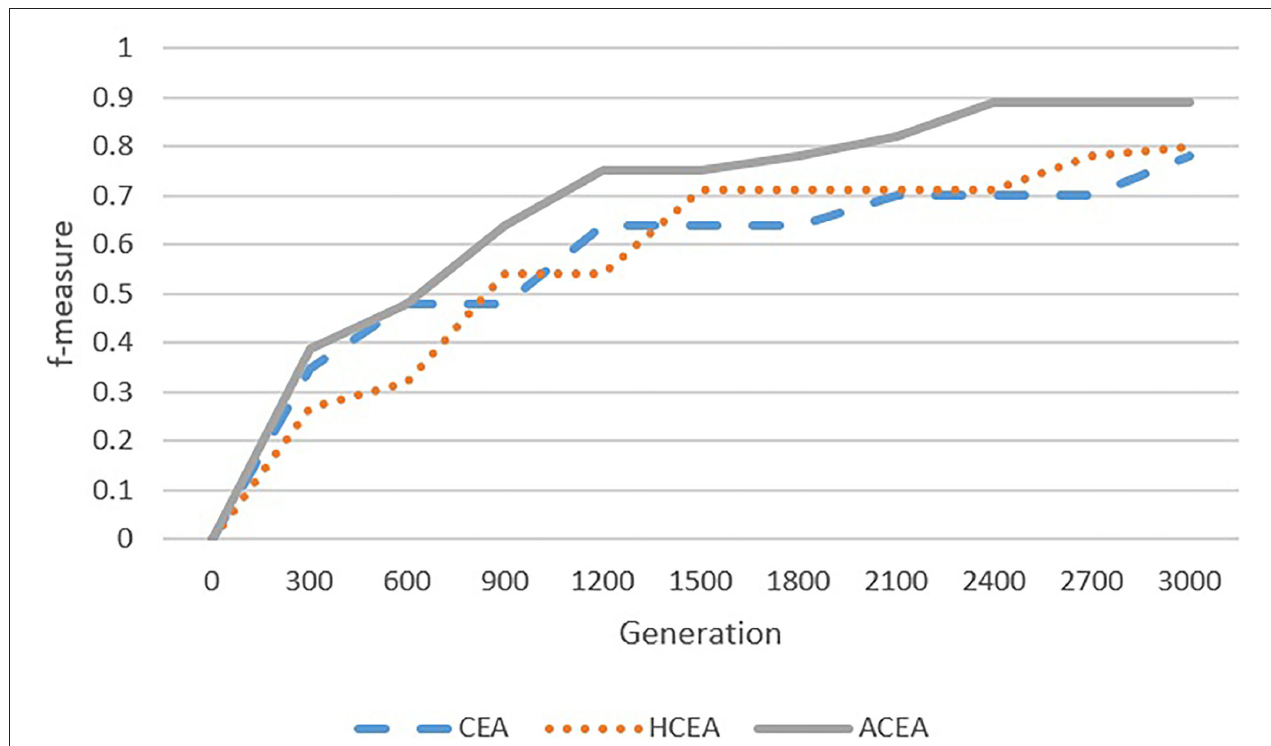
FIGURE 8 | Comparison among ACEA, CEA, and HCEA in terms of convergence graph on